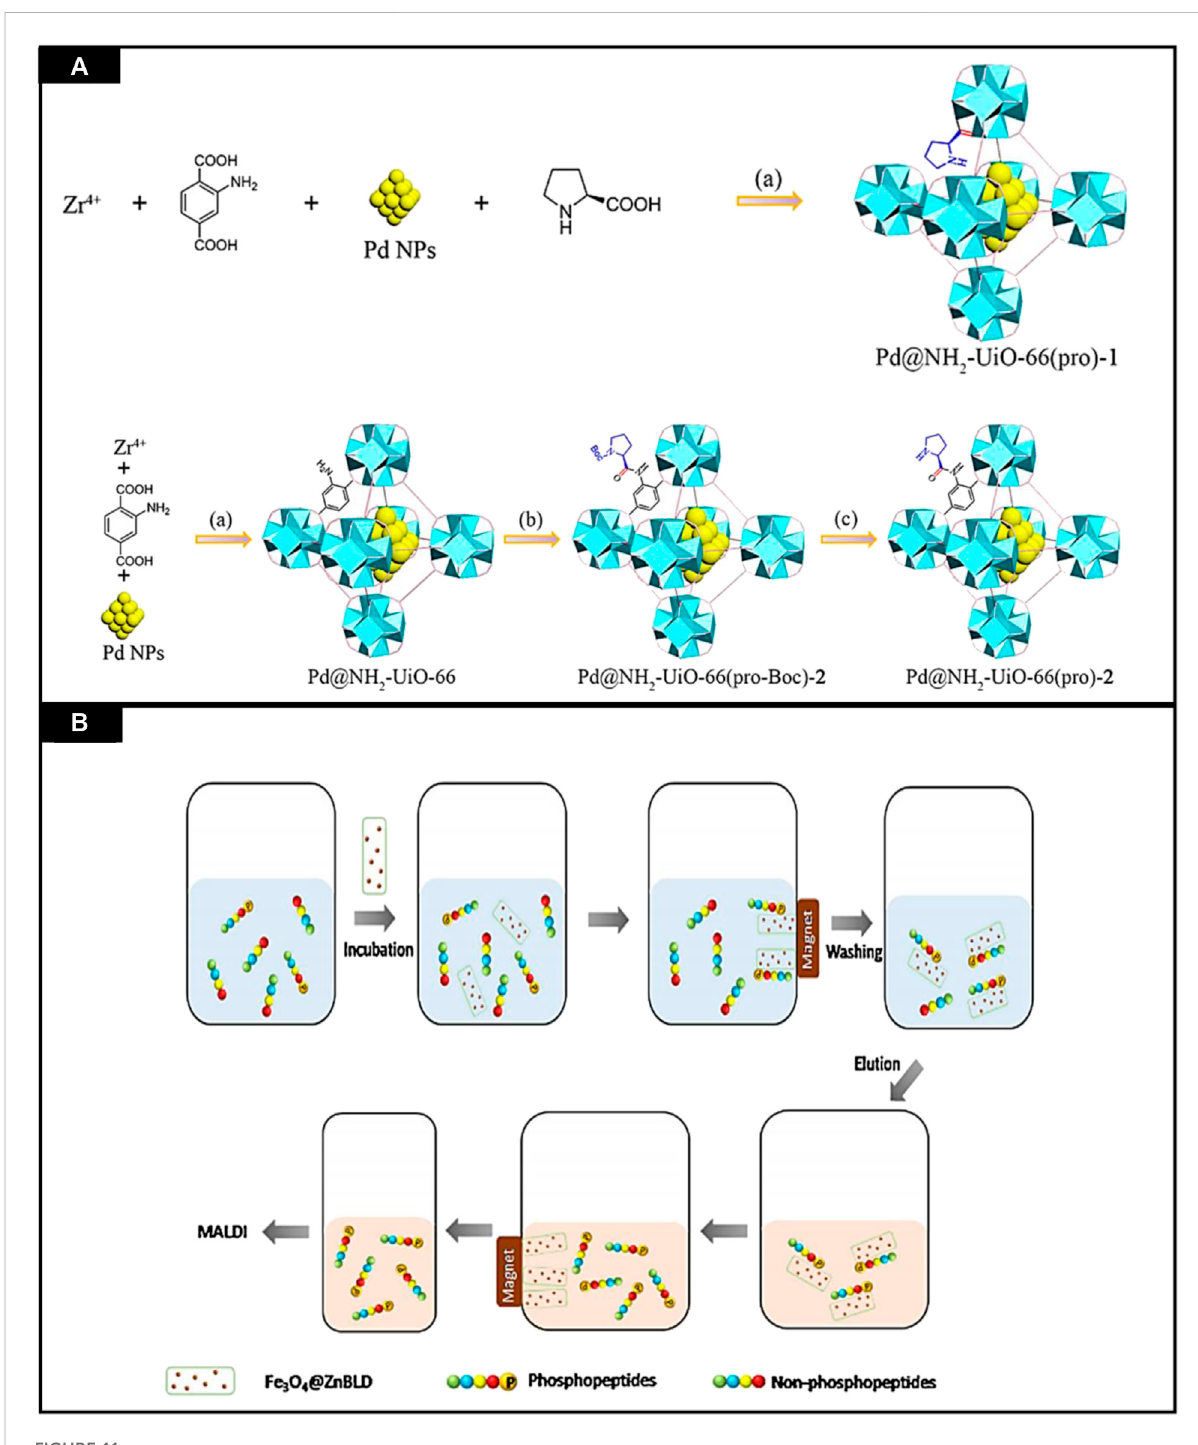
FIGURE 11 (A) Synthesis of Pd@NH 2 -UiO-66 (pro)-1 and Pd@NH 2 -UiO-66 (pro)-2 catalyst. Reproduced with permission from (Wu et al., 2015) (B) Phosphopeptides selective capturing by using Fe 3 O 4 @ZnBLD composites. Reproduced with permission from (Gu et al.,